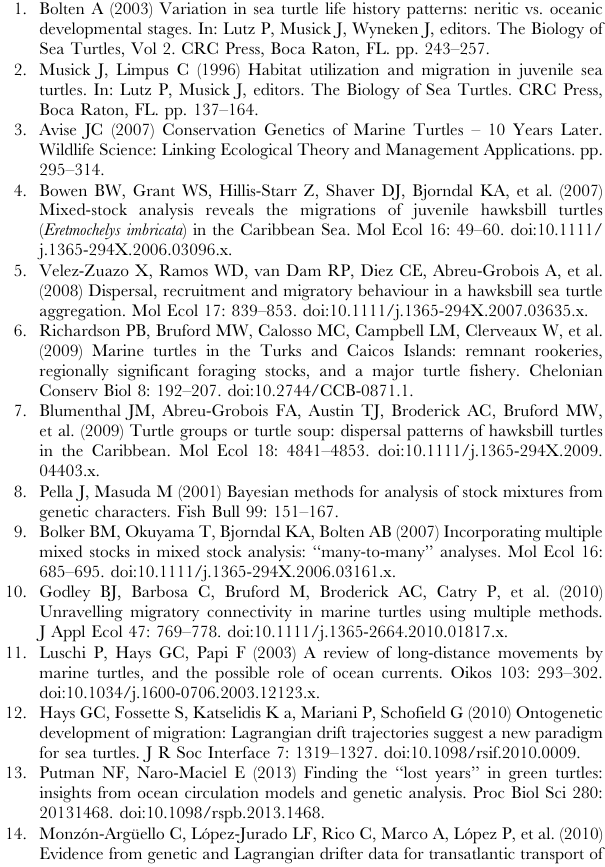
Figure S1 Feeding ground-centric many-to-many MSA estimates for Atlantic feeding populations. BS= Bahia/ Sergipe, PI = Pipa, PP= Principe, BB = Barbados, GU= Guadeloupe, AB= Antigua & Barbuda, UV= U.S. Virgin Islands, PR = Puerto Rico, DR = Dominican Republic, CU = Cuba, CR= Costa Rica, NI= Nicaragua, MX = Mexico. Figure S2 Rookery-centric many-to-many MSA esti- mates for Atlantic nesting populations. SP = Sa˜o Pedro and Sa˜o Paulo, CE = Ceara´ coast, BA = Bahia coast, AP= Abrolhos Park, SB= South Brazil, NR = Noronha/Rocas, PP= Principe, CV= Cape Verde, UV = U.S. Virgin Islands, PR = Puerto Rico, DR = Dominican Republic, TC= Turks & Caicos, BH = Bahamas, CU = Cuba, CY= Cayman Islands, MX = Mexico, TX = Texas, FL= Florida, UN= Unknown. Figure S3 Pathways of drifters passing by Atlantic Ocean rookeries. Colors indicate drift time (in months). Grey squares = drifter release areas around the rookeries, red circles = Brazilian feeding grounds, grey circles = other Atlantic Ocean feeding grounds. Grey arrows indicate the flow of the major Atlantic Ocean currents: SE = South Equatorial Current, BR = Brazil Current, SA= South Atlantic Current (displaced to the North for illustrative purposes), BG = Benguela Current, NB= North Brazil Current, GU= Guiana Current, CB= Caribbean Current, EC = Equatorial Counter Current, NE = North